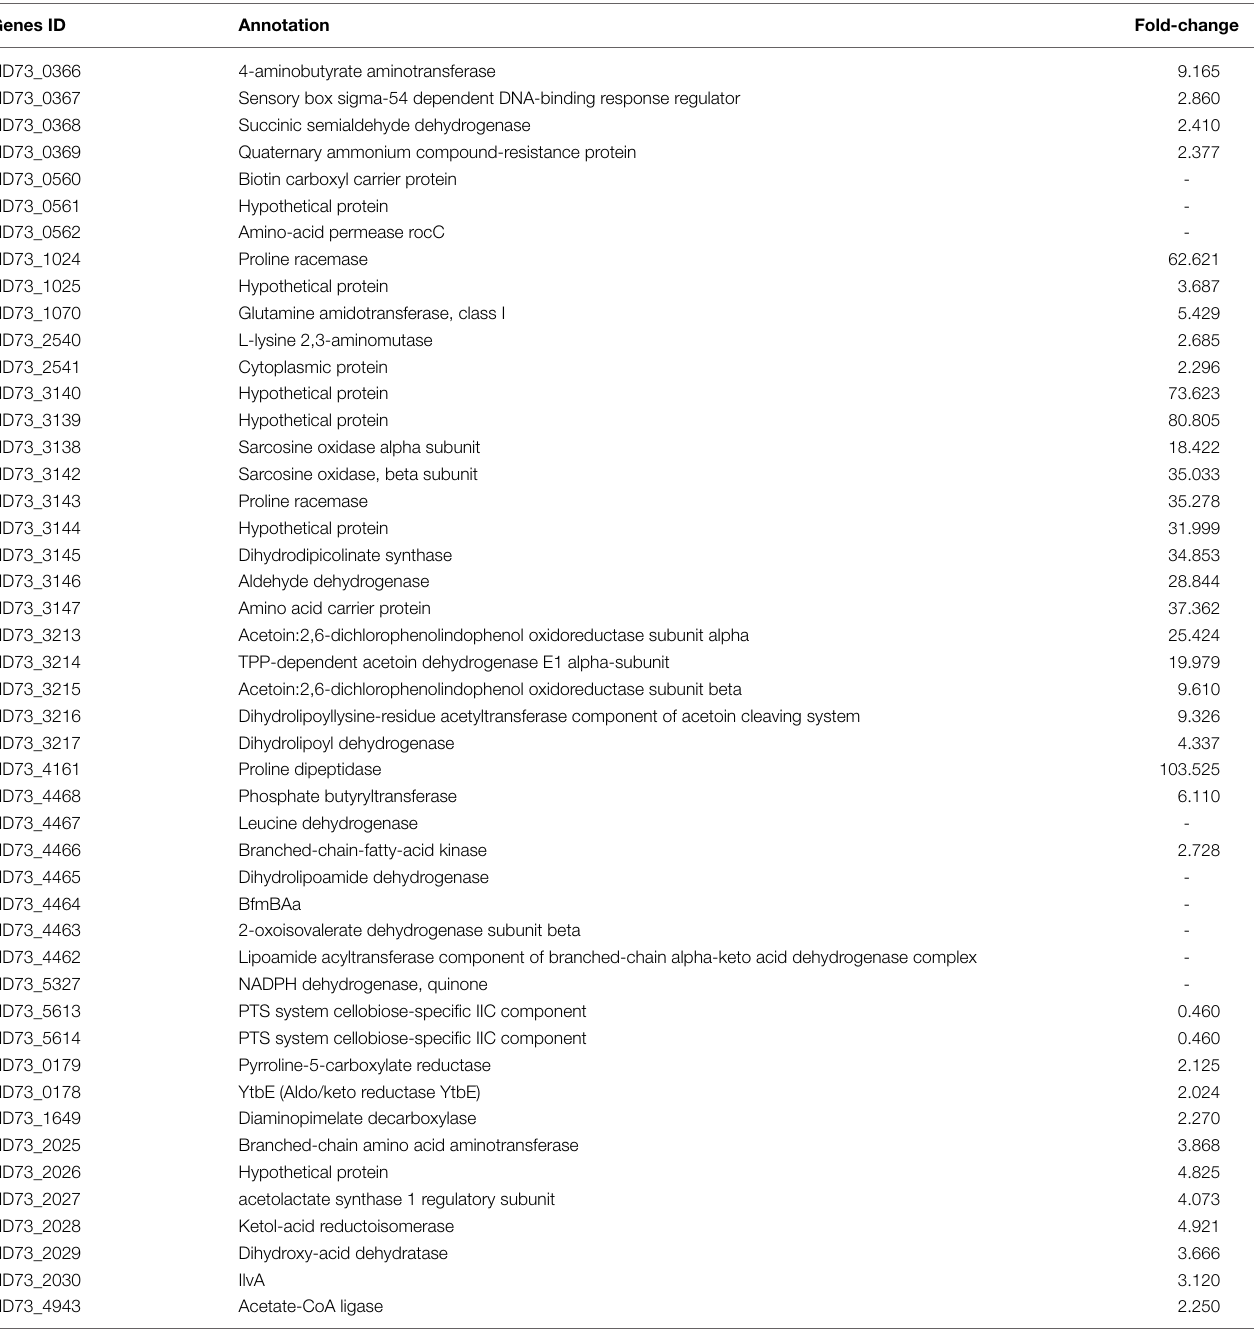
TABLE 3 | Genes controlled by σ 54 in B. thuringiensis HD73. Genes